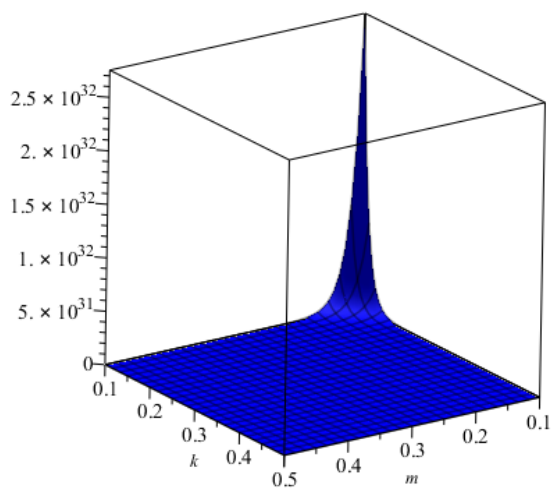
Figure 8. The graphically representation of the atom-bond connectivity index ABC 5 ( OX n )